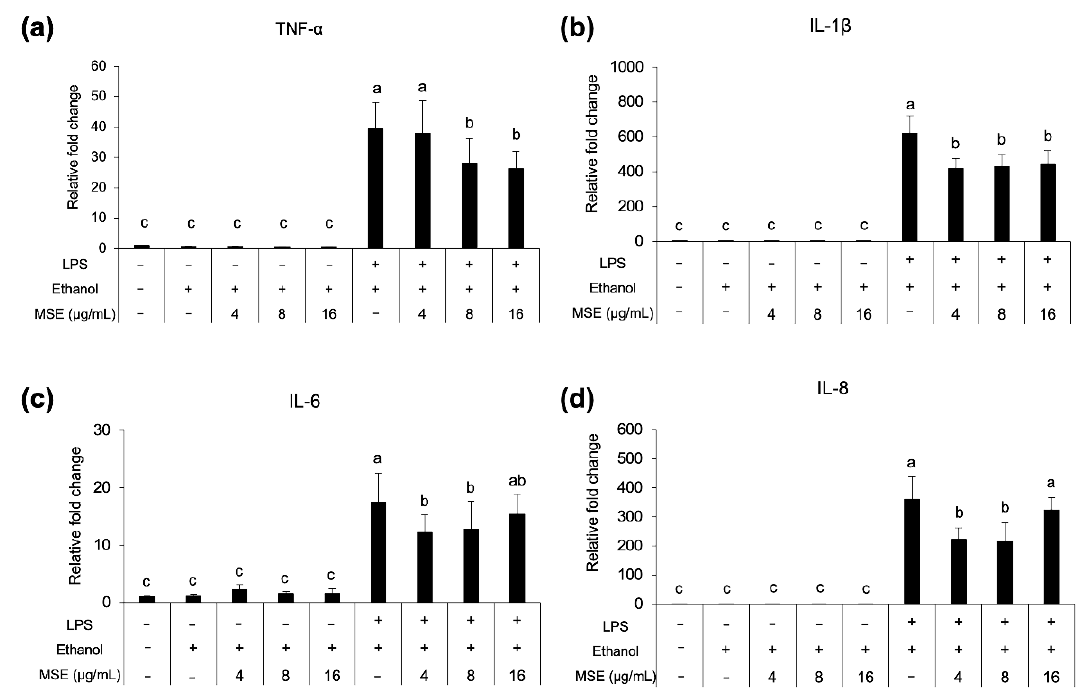
Figure 6. Proinflammatory cytokine gene TNF- α ( a ), IL-1 β ( b ), IL-6 ( c ) and IL-8 ( d ), expression of THP-1 monocytes treated with MSE with and without LPS stimulation and nonstimulated cells (control). Statistical analyses were performed using Tukey’s posthoc test and one-way analysis of variance (ANOVA). Values are expressed as the mean ± SD ( n = 3). Different letters indicate statistical differences ( p < 0.05).